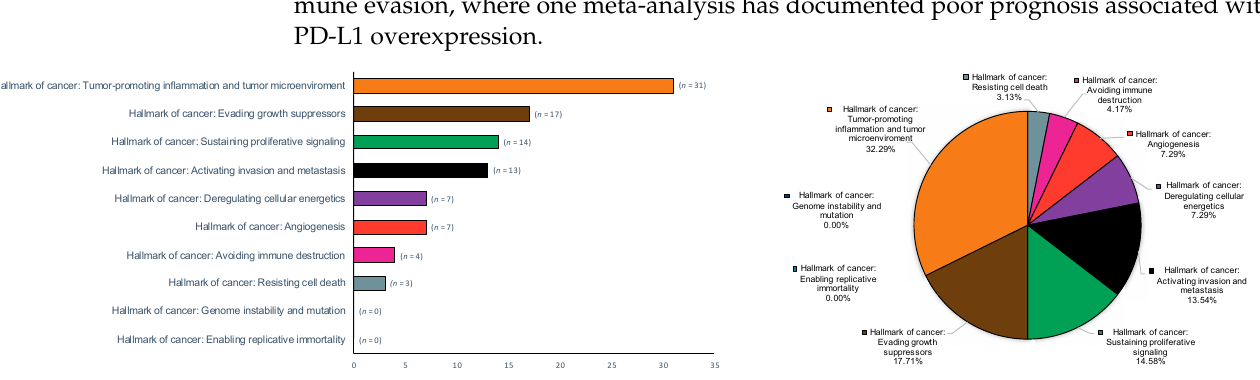
Figure 5. Bar and pie charts graphically summarizing the evidence derived from the research on hallmarks of oral and oropharyngeal carcinogenesis across secondary ‐ level systematic reviews and meta ‐ analyses. Hallmarks of cancer were ordered by absolute counts ( left , bar chart) and relative frequencies by calculating raw proportions, expressed as percentages ( right , pie chart).